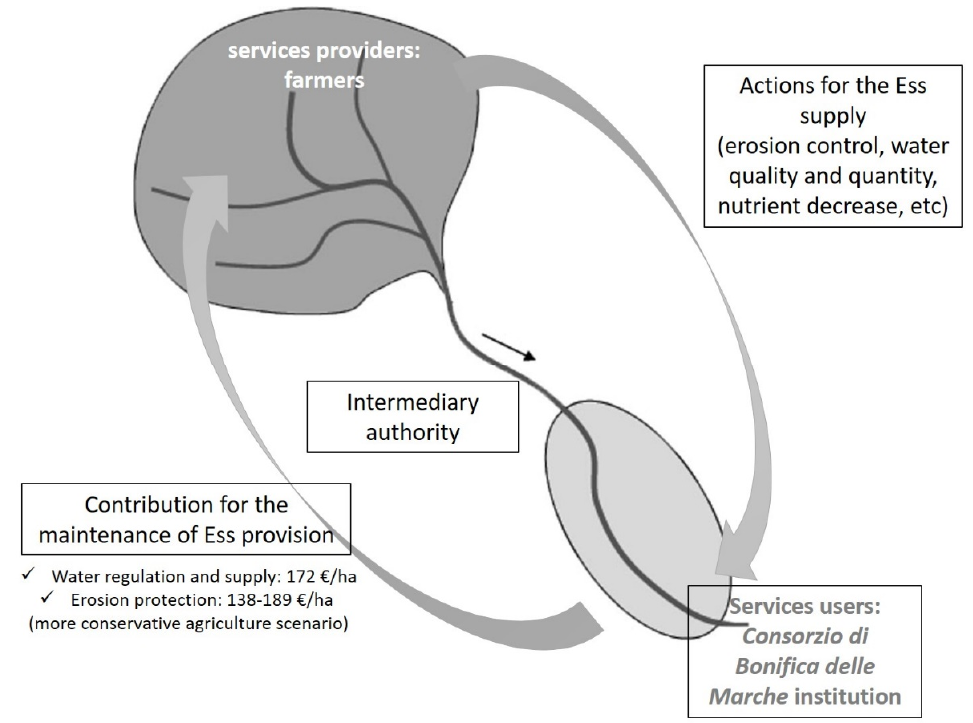
Figure 5. Hypothetic PES scheme (elaborated from Pagiola and Platais [87]) with Ecosystem Services values provided by farmers with actions as proposed in scenario T3.